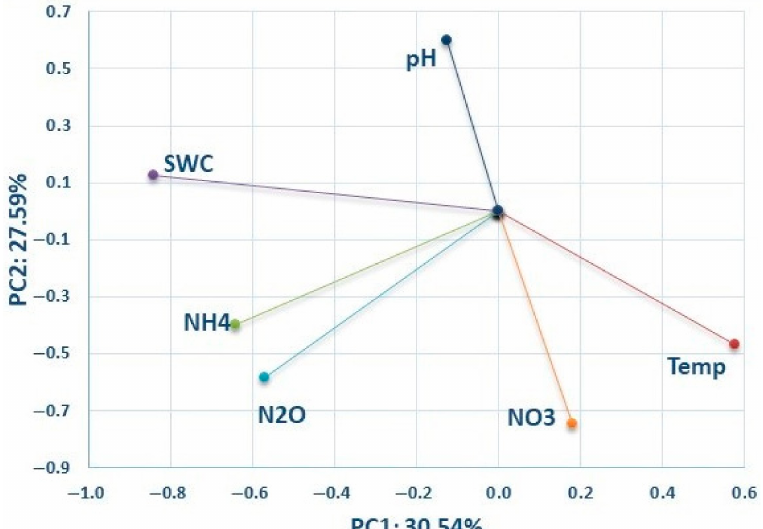
Figure 5. A biplot of the first two components of a PCA model of the biochar data for all dates, presenting the relationship between variables: SWC—soil water content (%), soil temperature ( ◦ C),